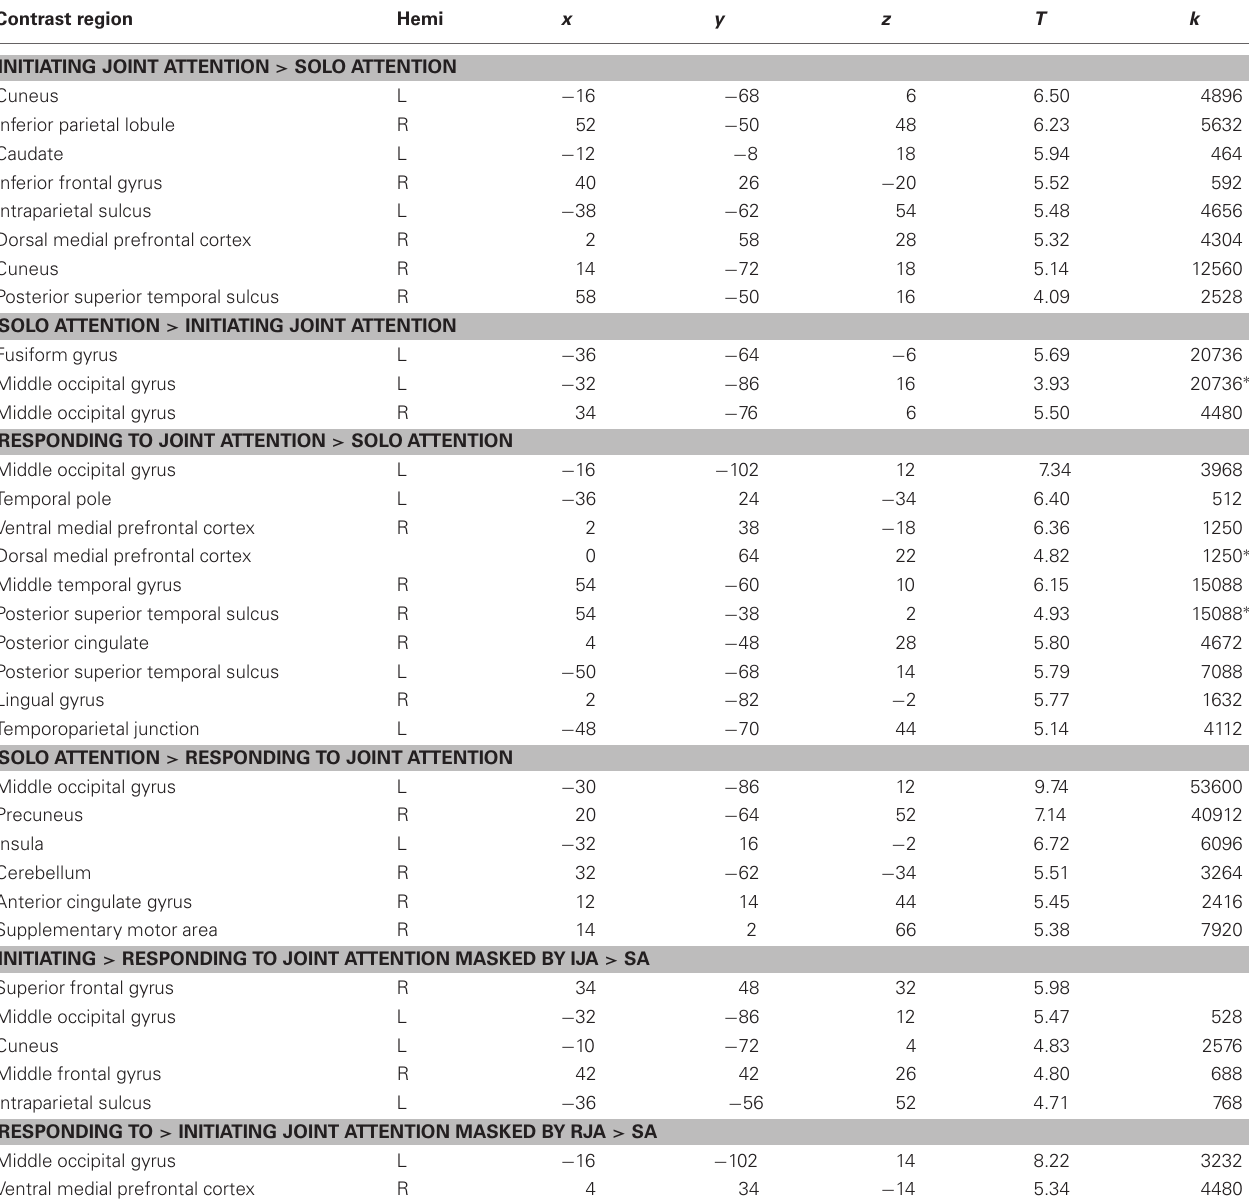
Table 2 | Comparisons between joint and solo attention